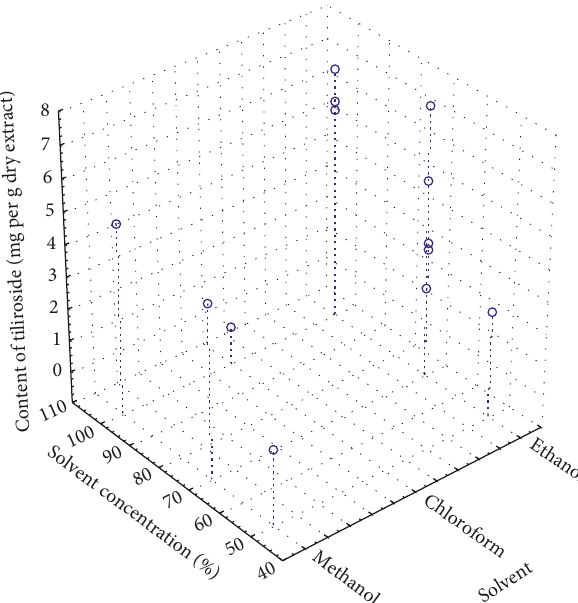
Figure 2: Spread chart 3W of the content of tiliroside vs. type of solvent and solvent concentration for ultrasound-assisted extrac- tion (UAE).